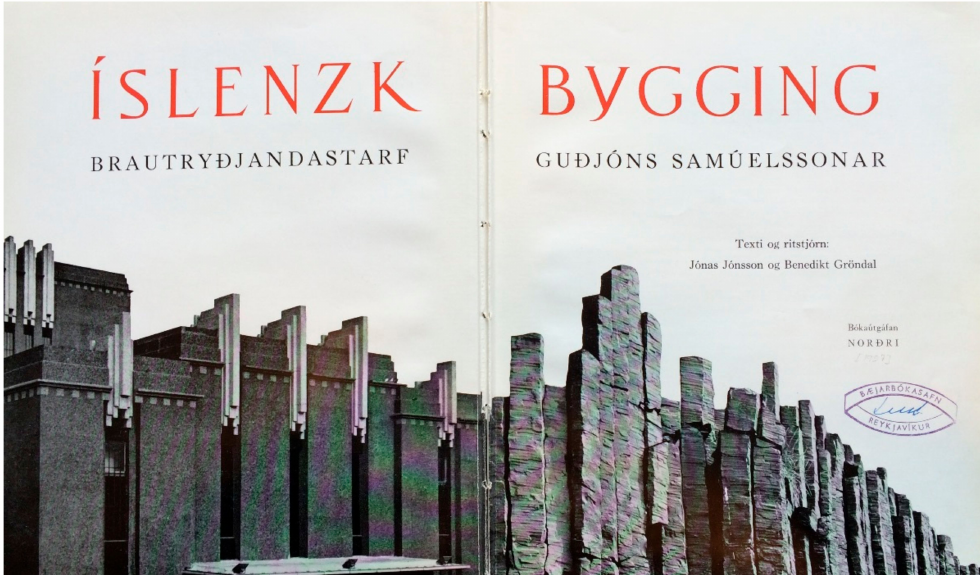
Figure 11. J ó nas J ó nsson, Í slenzk Bygging: Brautryðjandastarf Guðj ó ns Sam ú elssonar , Reykjav í k: Norðri, 1957. Copy available at the Reykjav í k City